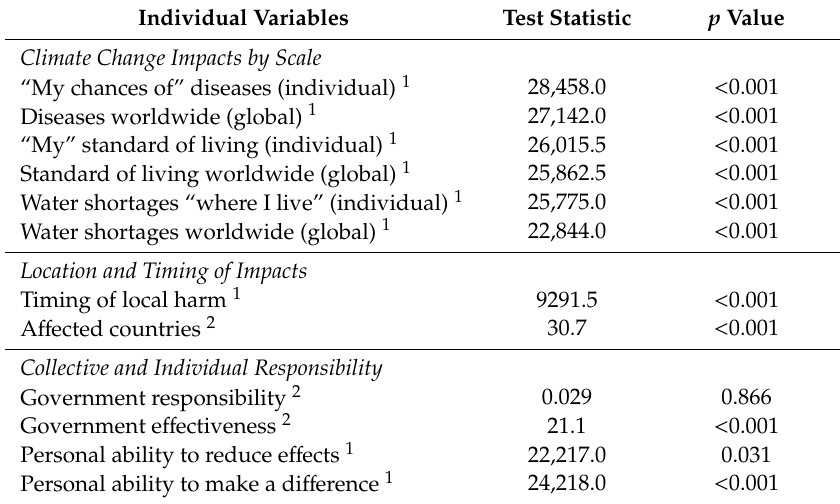
Table 4. Statistical tests of di ff erences based on development